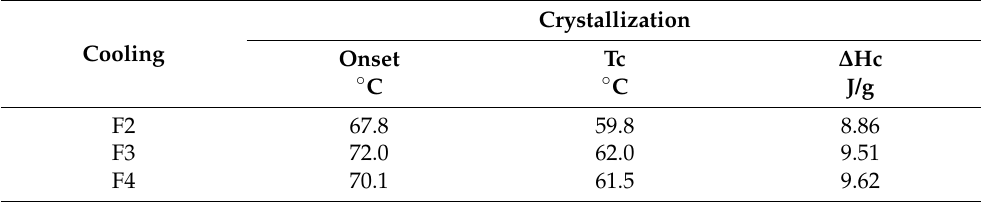
Table 8. Cooling of studied primary compounds.